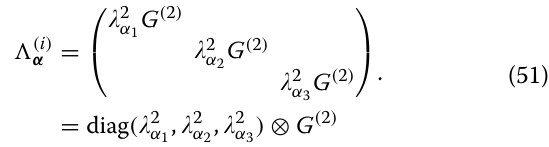
We use the same regularization parameter matrix element spline and for all Cryosat/DMSP instru- ments, and similarly for the offsets (